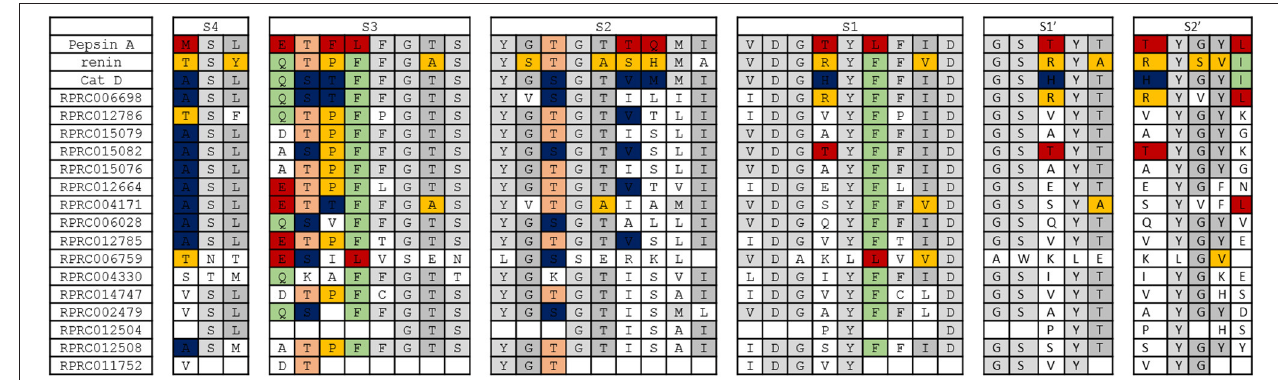
FIGURE 8 | Overall view of residues involved in substrate binding across subsites S4 to S2 ′ in the active site of selected peptidases of family A1 and corresponding residues in R. prolixus homologous sequences. The background color of residues shows their presence in the archetype sequences of pepsin, renin and cathepsin D. Residues exclusive to pepsin, renin and cathepsin D are colored in red, yellow and blue, respectively. Residues common to pepsin and renin are colored in light orange, those common to renin and cathepsin D in light green and those common to pepsin and cathepsin D in light gray. Residues that are common to pepsin, renin and cathepsin D are shown in a gray tone that is even lighter than the above.